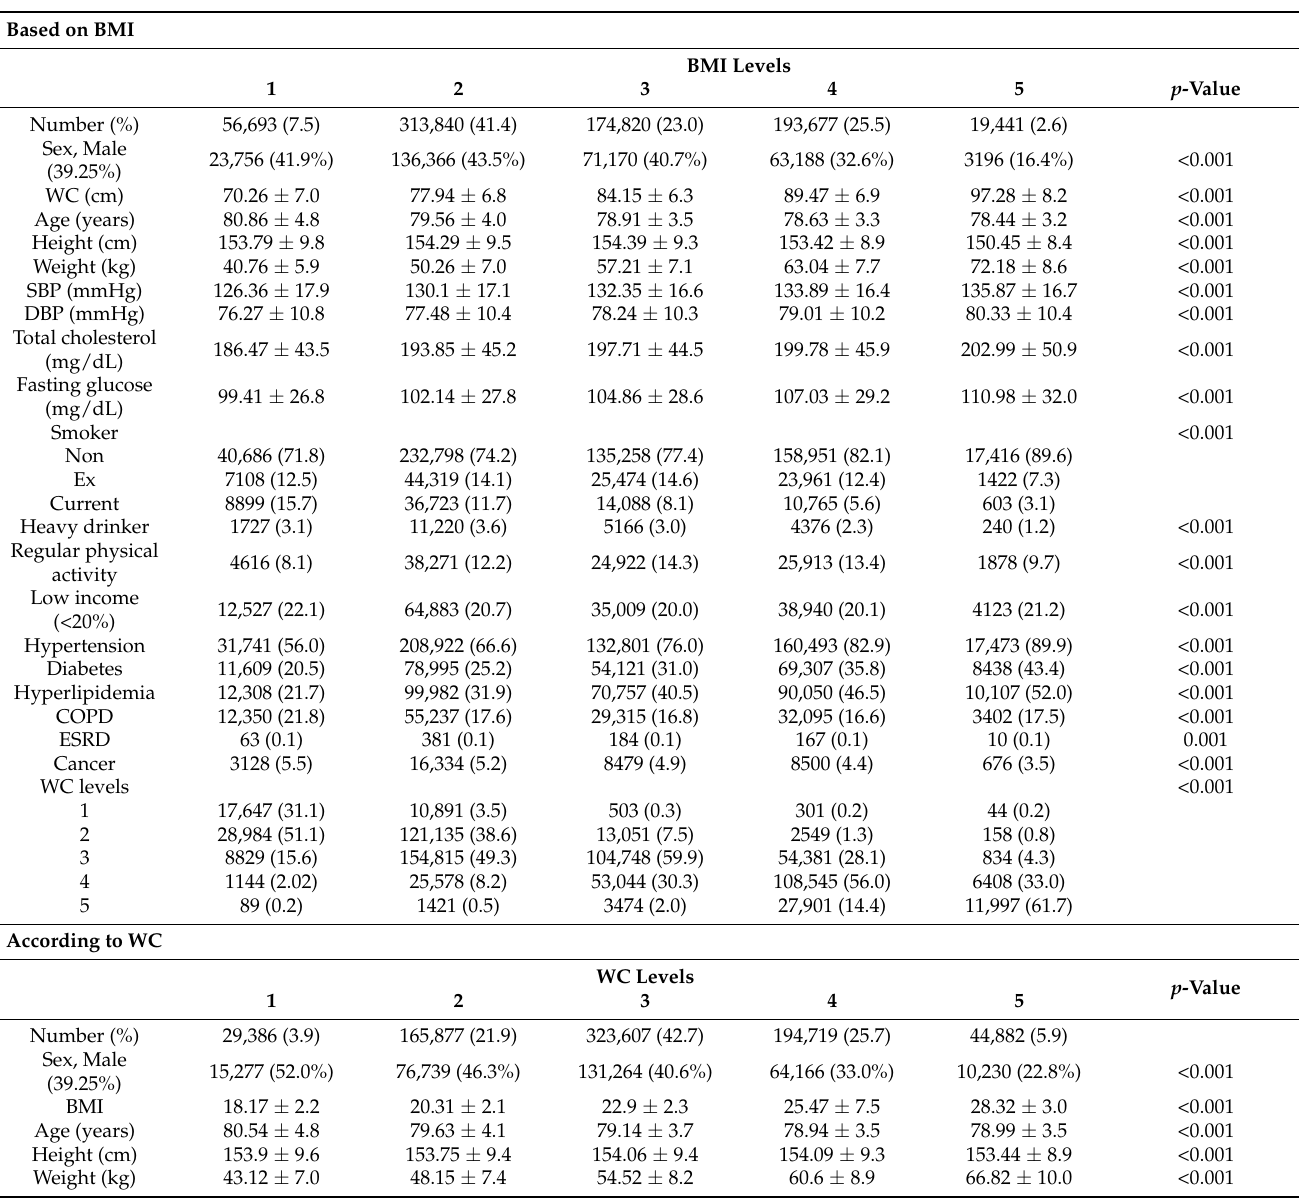
Table 1. General characteristics of